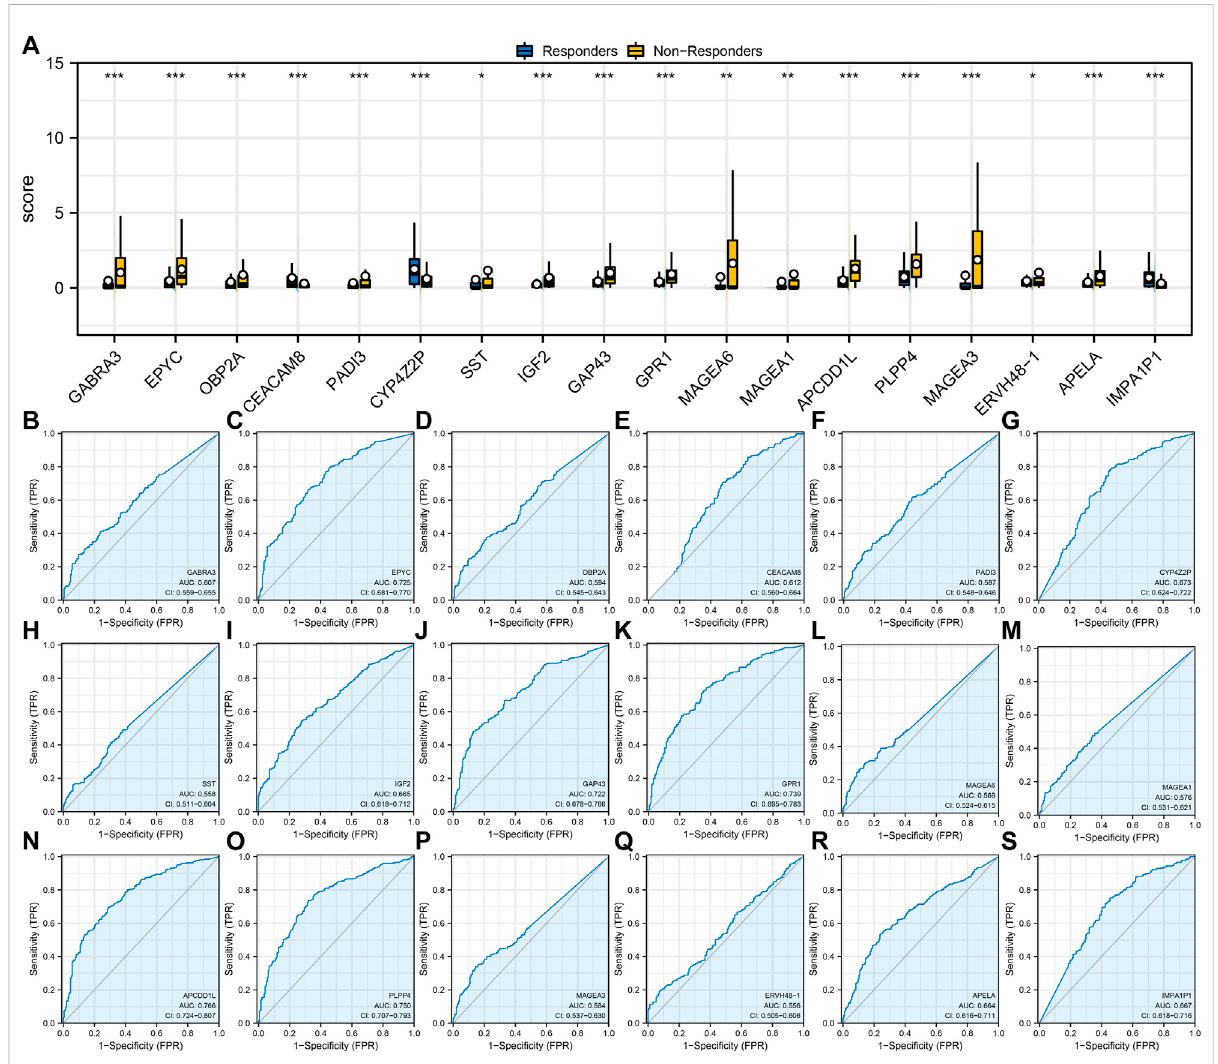
FIGURE 2 Evaluation of the prediction performance of immunotherapy characteristic genes. Notes: (A) Expression level of identi fi ed 18 characteristic genes in immunotherapy responders and non-responders; (B – S) : Prediction performance of 18 characteristic genes in LUAD immunotherapy